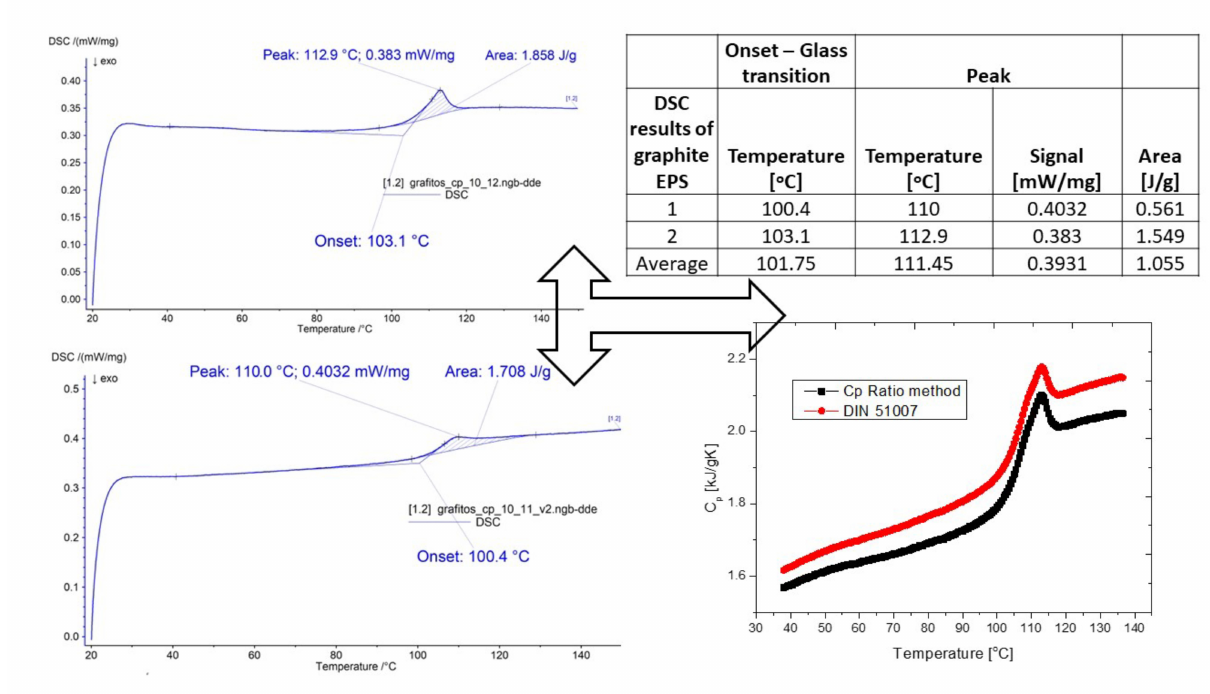
Figure 2. The measurement results of the graphite EPS samples with the DSC